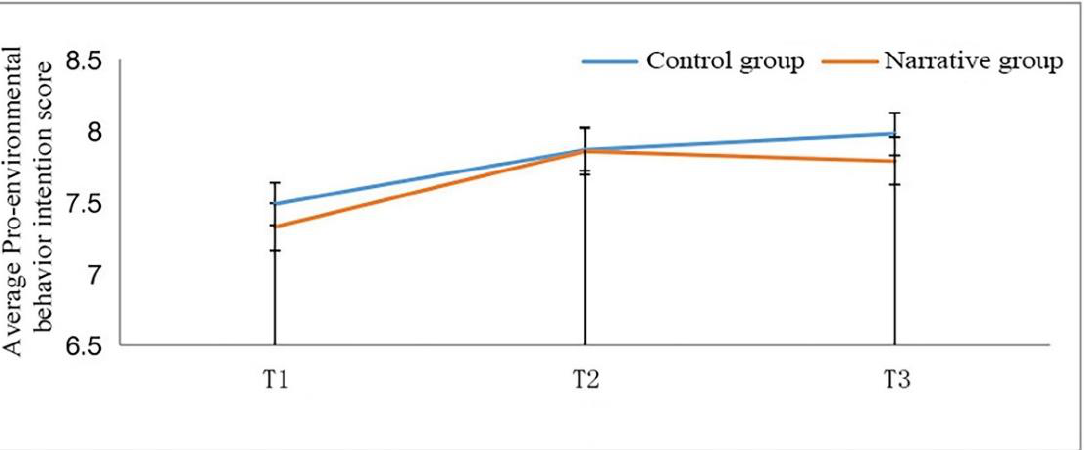
Figure 3. Two-factor repeated-measures ANOVA of children’s pro-environmental behavior intention.